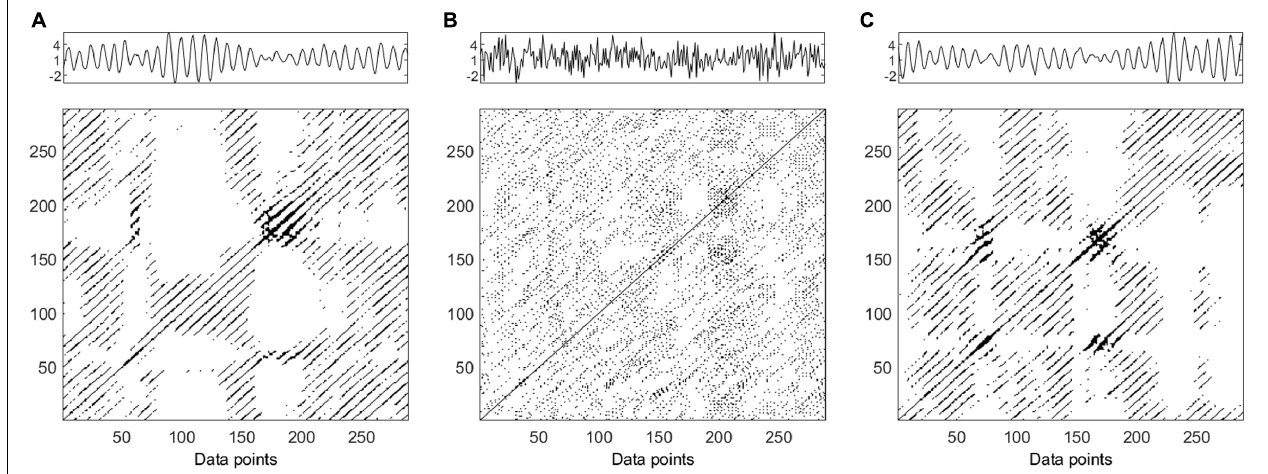
FIGURE 3 | Time series and recurrence plot ( m = 5, τ = 3) for synthetic data AR2ns Eq. (2). Original time series (panel A) , one surrogate obtained by Iterative Amplitude Adjusted Fourier Transform (IAAFT) (panel B) and one surrogate obtained by Pinned Wavelet Iterative Amplitude Adjusted Fourier Transform (PWIAAFT) (panel C) . Time series in all panels are shown as arbitrary